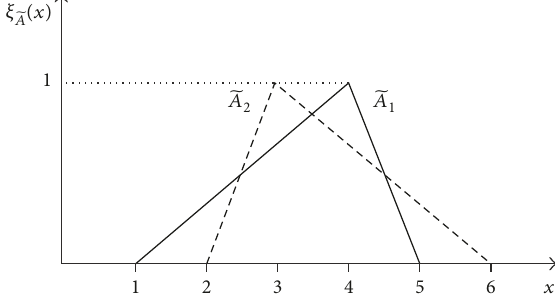
Table 2: Ranking results for Example